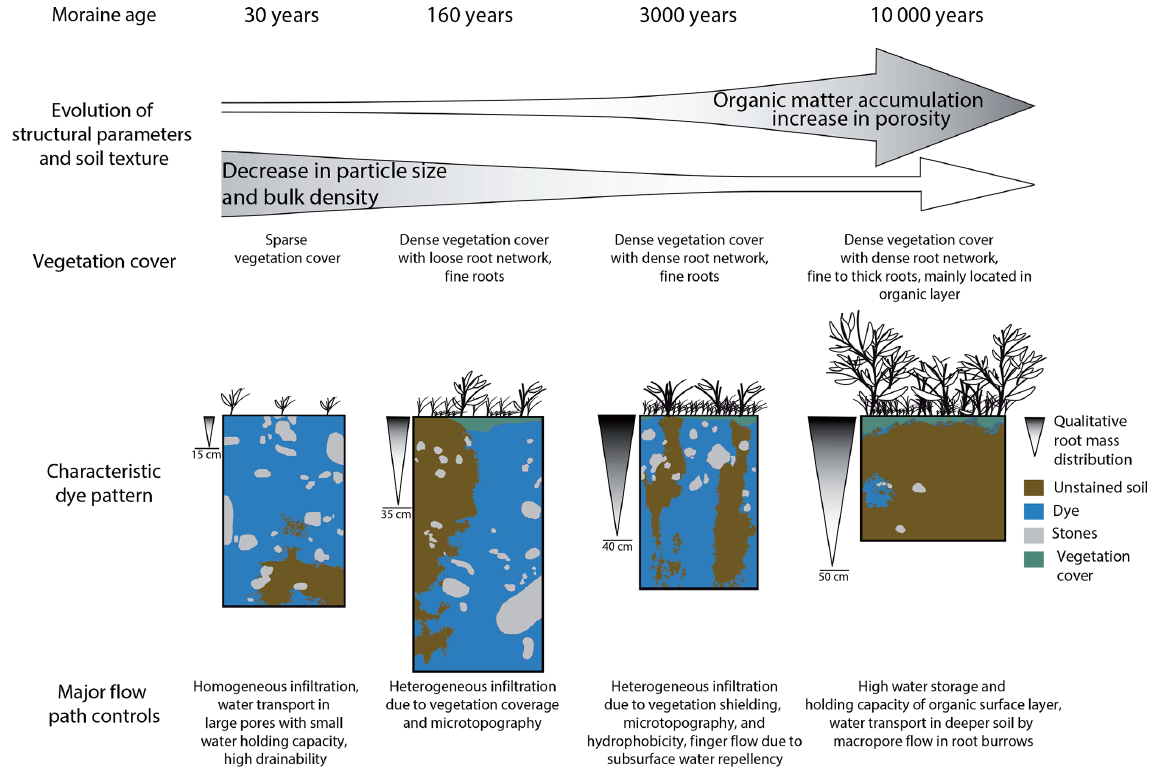
Figure 11. Sequence of observed characteristic dye patterns and derived flow path controls compared to the qualitative evolution of soil texture, structural parameters, and vegetation. The shade of the root mass distribution triangles is a measure for the vertical root mass distribution with a darker color indicating a higher root mass. The width of the triangles is a measure for the root mass comparison between the moraine ages, with broader triangles indicating a higher root